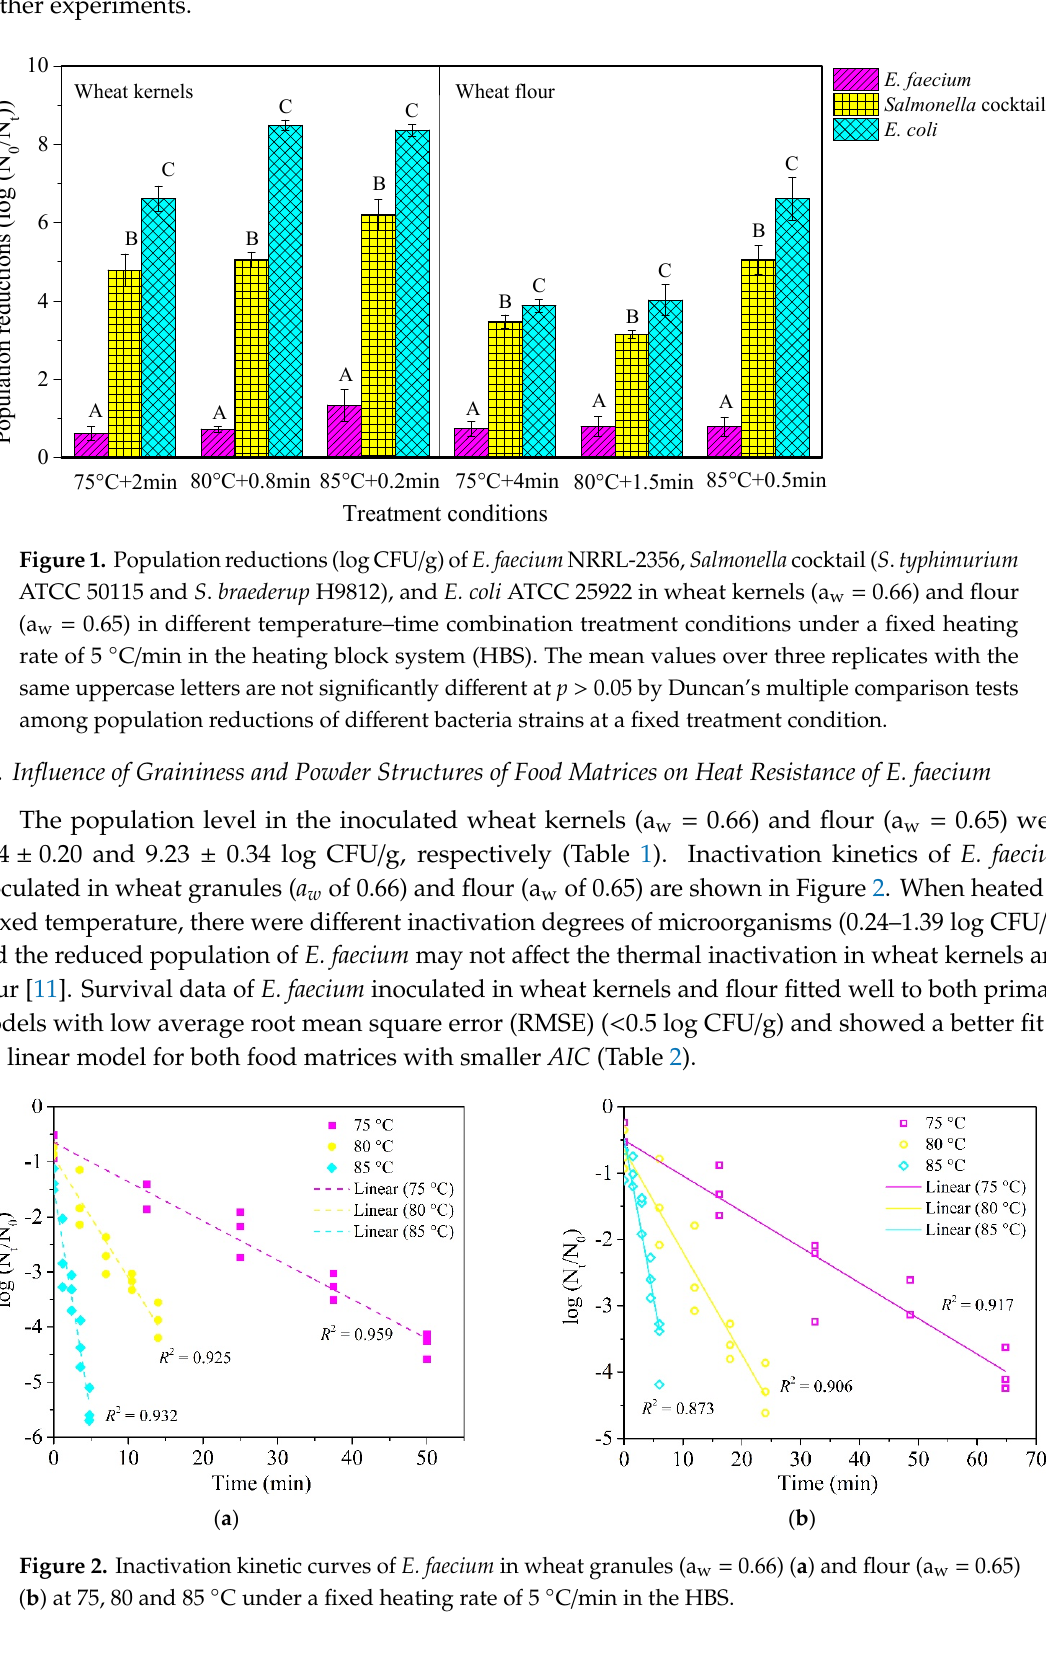
( a ) ( b ) Figure 3. Inactivation kinetic curves of E. faecium in wheat granules ( a ) (a w = 0.99) and dough ( b ) (a w = 0.99) at 60, 62 and 64 °C under a fixed heating rate of 5 °C/min in the HBS. The authors apologize for any inconvenience caused to the readers by these changes. The changes do not affect the scholarly results. The original manuscript will be updated online. References 1. Lin, B.; Zhu, Y.; Zhang, L.; Xu, R.; Guan, X.; Kou, X.; Wang, S. Effect of physical structures of food matrices on heat resistance of Enterococcus faecium NRRL ‐ 2356 in wheat kernels, flour and dough. Foods 2020 , 9 , 1890, doi:10.3390/foods9121890.